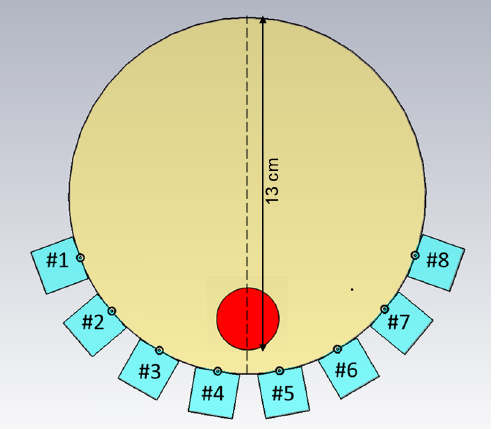
Figure 6. Schematic illustration of the measurement setup, including the position of the blood phantom, as well as the position of the transect cutting through the middle of the phantom. Antennae are numbered